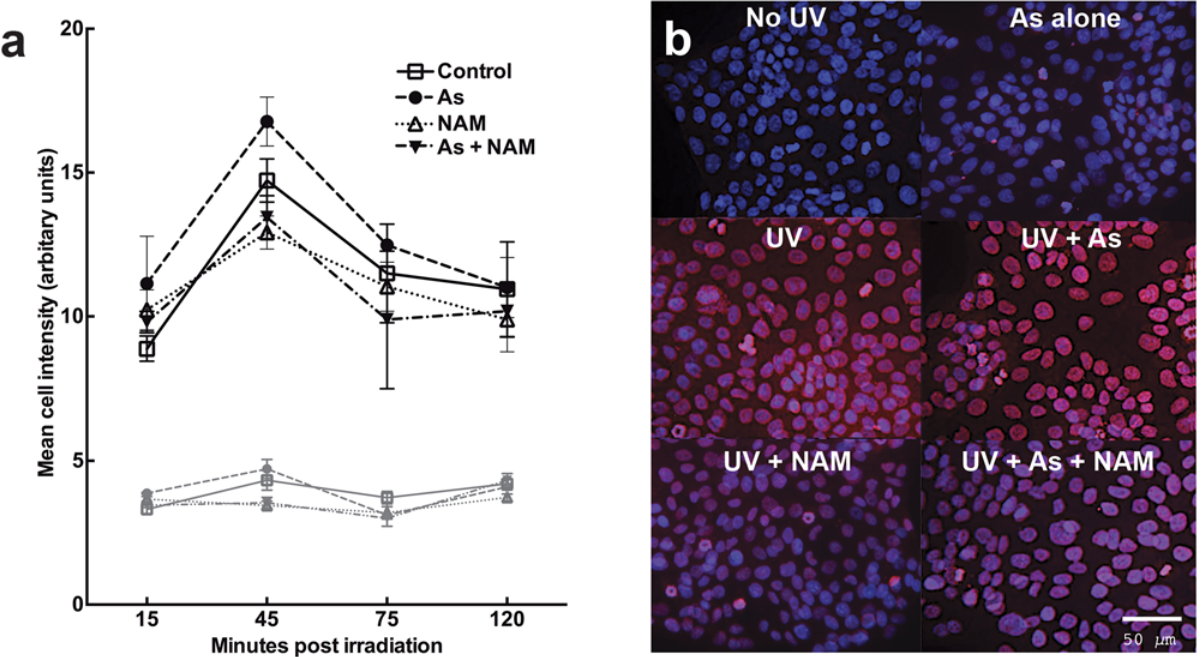
Fig 4. Nicotinamide (NAM) reduced arsenic (As) and UV-induced CPDs in HaCaT keratinocytes over time (a). The cells were stained for CPDs with grey lines representing unirradiated groups. The mean of each timepoint is displayed ± SEM (n = 3). Significant differences included UV vs no UV (p < 0.01), UV vs UV + NAM (p < 0.05) and UV + As vs UV + As + NAM (p < 0.05) two way ANOVA. Staining of CPDs 45 minutes following UV radiation, arsenic and nicotinamide exposure in HaCaT keratinocytes and in unirradiated keratinocytes (b) . The blue staining represents DAPI (nuclear staining). The red staining represents CPD